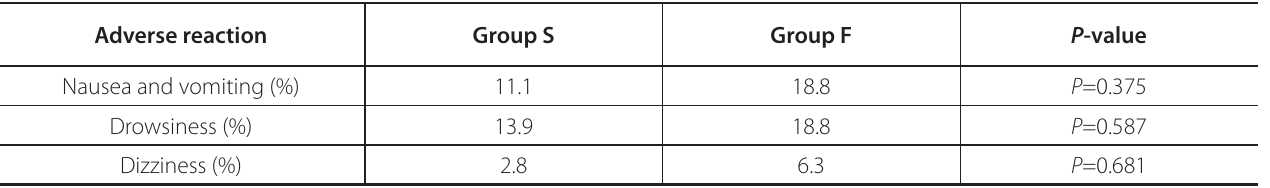
Table 3 . Comparison of minor complications in both groups.